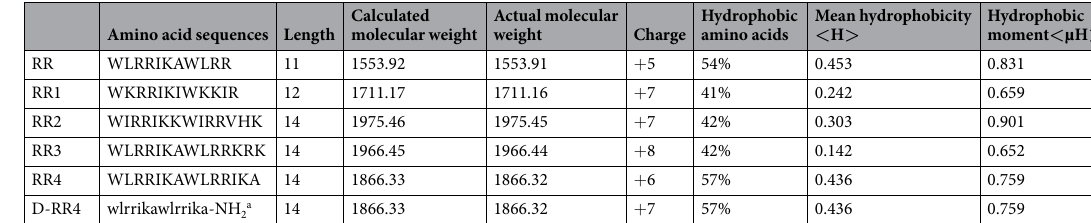
Table 1. Amino acid sequence and physicochemical properties of peptides used in this study. a Small underlined residues represent D-amino